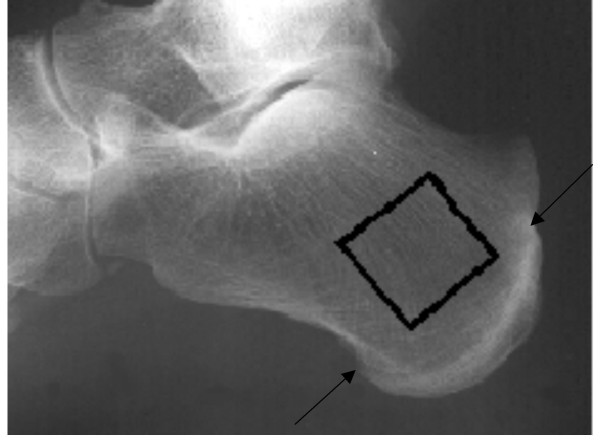
Radiographic image of the calcaneus showing the localization of the Region of Interest (ROI). Inside the ROI, longitudinal trabeculae correspond to the compressive trabecular network extended from the subtalar joint and the transverse to the tensile trabecular network sweeping backwards and upwards the great tuberosity. Arrows show anatomical landmarks corresponding to the bottom of the ROI.